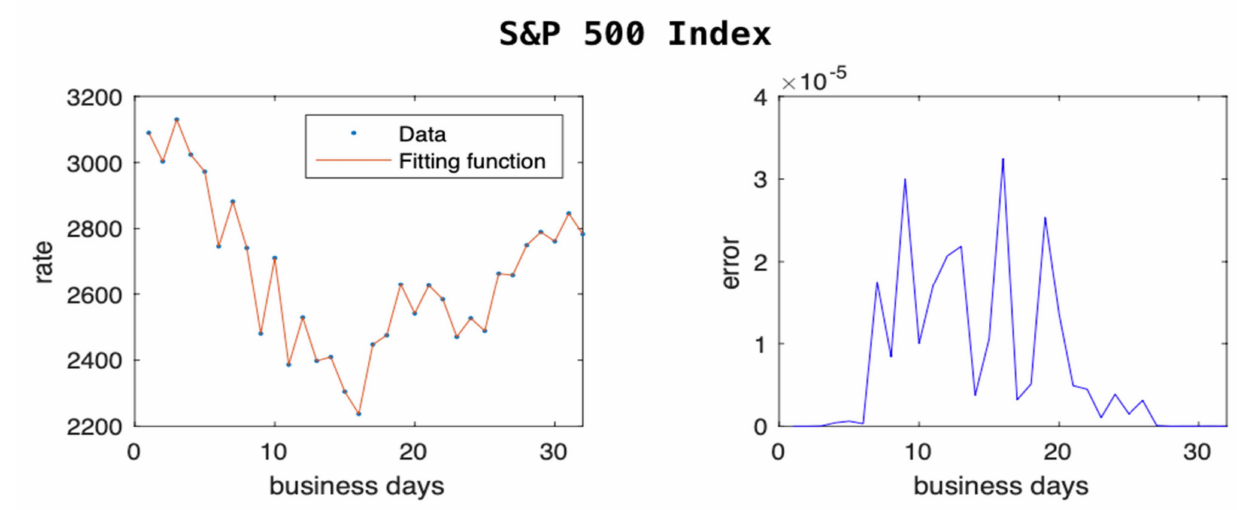
Figure 2. Fitting S&P 500 index values during 2020 stock market crash. Fitting function of S&P500 Index values from 1 March 2020 to 15 April 2020. N = 65, error range is [3.7289 × 10 − 11 , 3.2482 × 10 − 5 ].